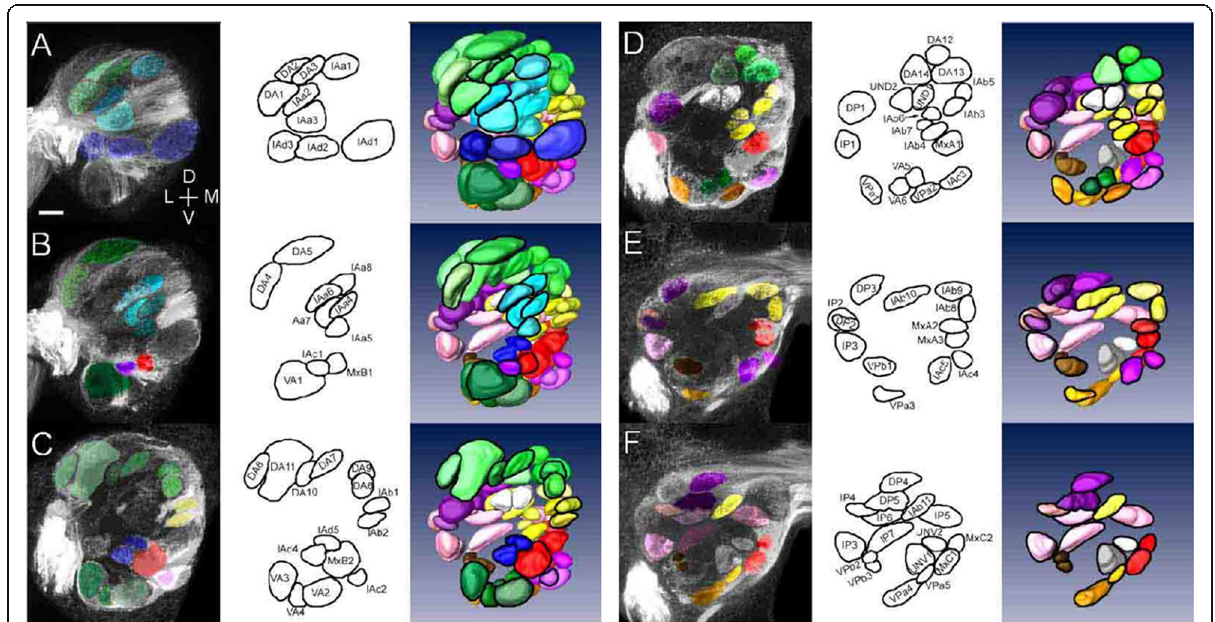
Fig. 4 Representative confocal stacks and partial three-dimensional reconstructions of the right AL. Six frontal planes through the AL from anterior to posterior ( a – f ) are shown. The color coding is identical to that of the subgroups of glomeruli (see Fig. 3 and Table 1). Left column: Each plane is a representative stack of 10 confocal images at 0.9- μ m intervals (stack size, 9 μ m). Colors are superimposed on the glomeruli identified in each confocal stack. Middle column: Identified and demarcated glomeruli (black outline). Right column: Partial three-dimensional reconstructions. The top panel a shows the whole pattern. The subsequent panels b – f show the structures of the inner glomeruli. The outlined glomeruli are the ones identified in each confocal stack in the left column. Bar indicates 20 μ